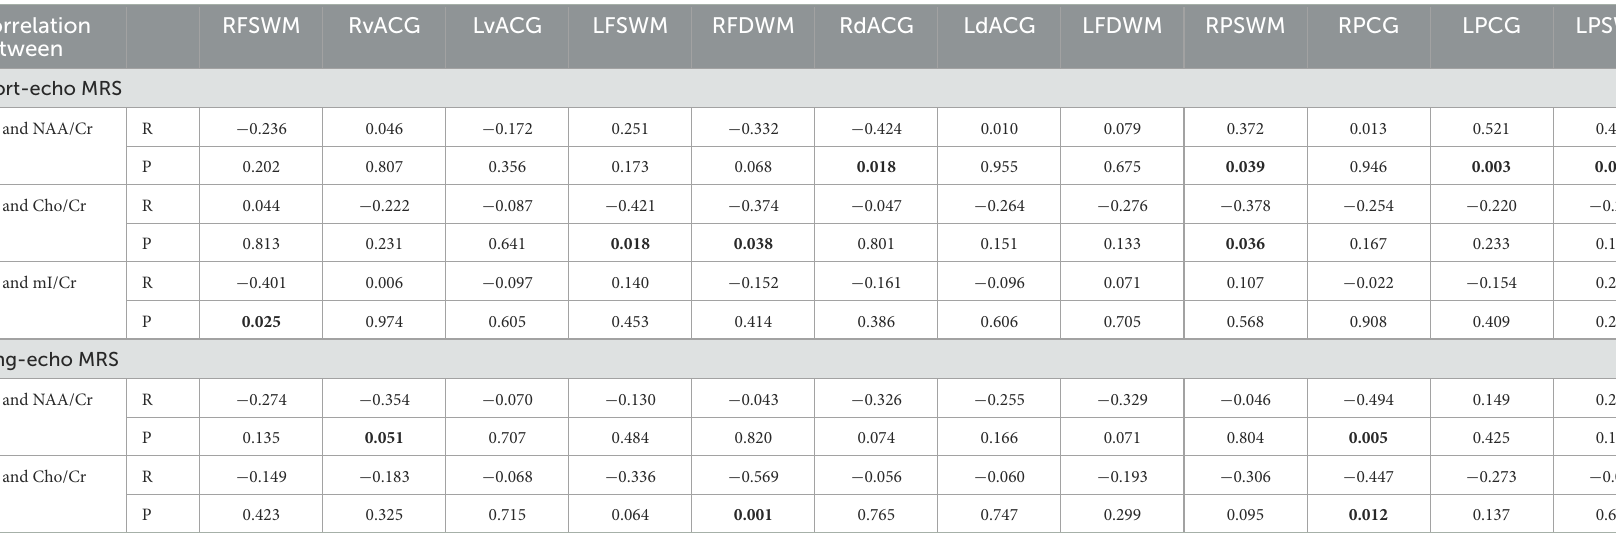
TABLE 4 Correlations between ME score and neurometabolite ratios, in analyzed brain regions ( r is presented in the upper row and p in the lower row in the cell). Correlation